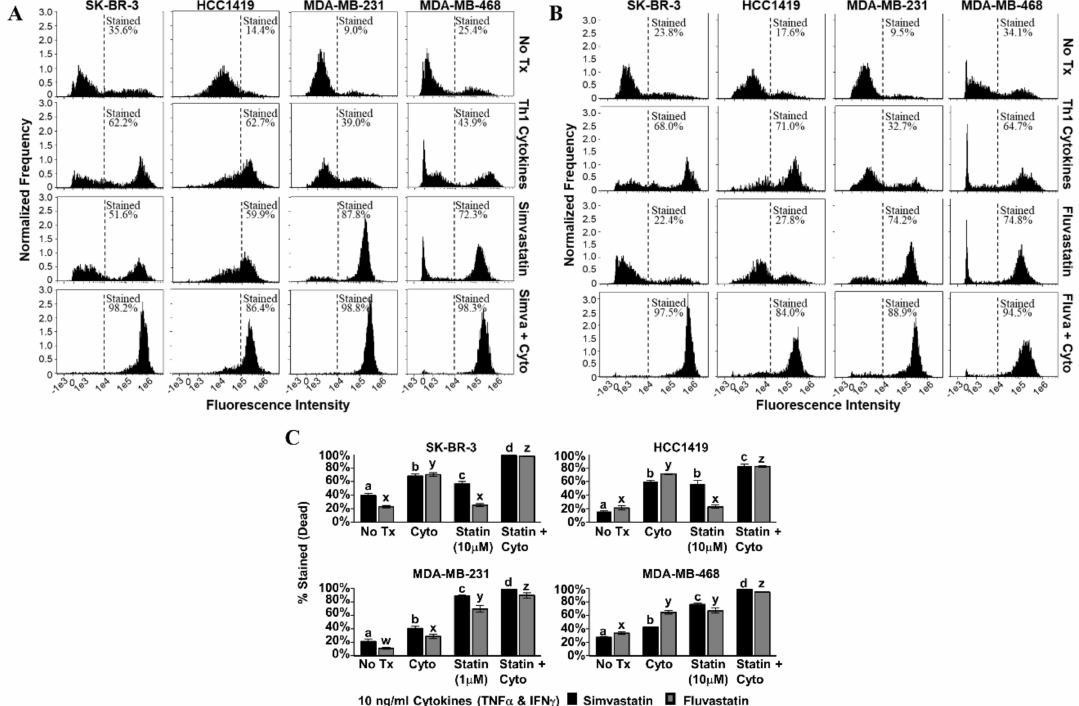
Figure 3. Combination of Th1 cytokines and statin drugs maximize cell death in breast cancer lines. SK-BR-3, HCC1419, MDA-MB-231, and MDA-MB-468 human breast cancer cell lines were cultured with no additives (No Tx), treated with recombinant Th1 cytokines (TNF- α and IFN- γ , 10 ng / mL each), a statin drug ( A ) Simvastatin or ( B ) Fluvastatin (1 µ M MDA-MB-231; 10 µ M remaining cell lines), or the combination of Th1 cytokines and a statin drug ( A ) “Simva + Cyto” or ( B ) “Fluva + Cyto”. Flow cytometric results displayed in panels A and B are from one representative experiment. ( C ) Graphical interpretation of gated flow cytometric results comparing the percentage of stained events between groups: no additives (No Tx), treated with recombinant Th1 cytokines (TNF α and IFN γ